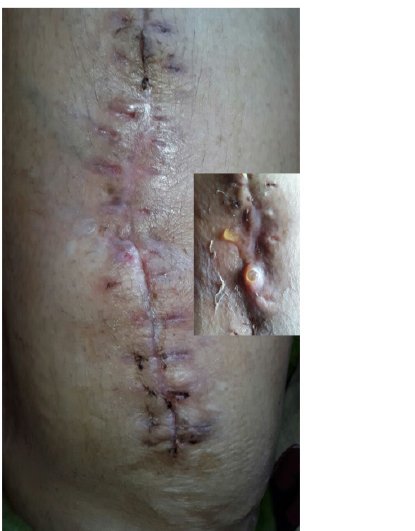
Figure 13. Serous discharge from surgical site